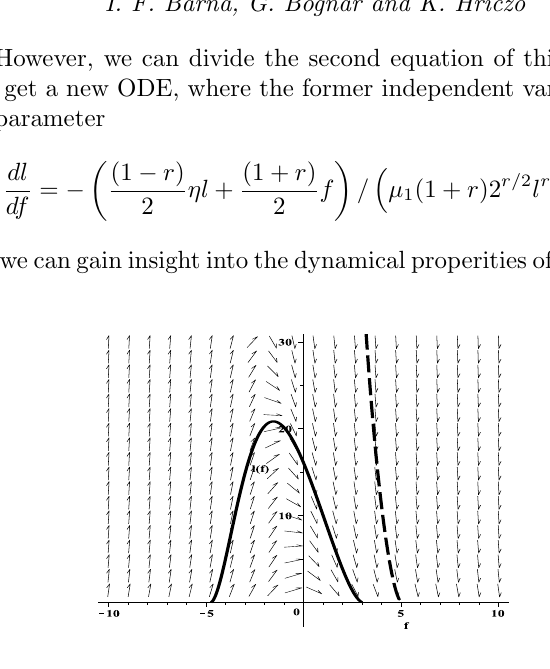
Figure 1. The phase portrait diagram of (3.1) for η = 0 . 03 ,r = − 0 . 425 and µ 1 = 0 . 18. The two different kind of trajectories: one with compact support (solid line), and the other one with compact range (dashed